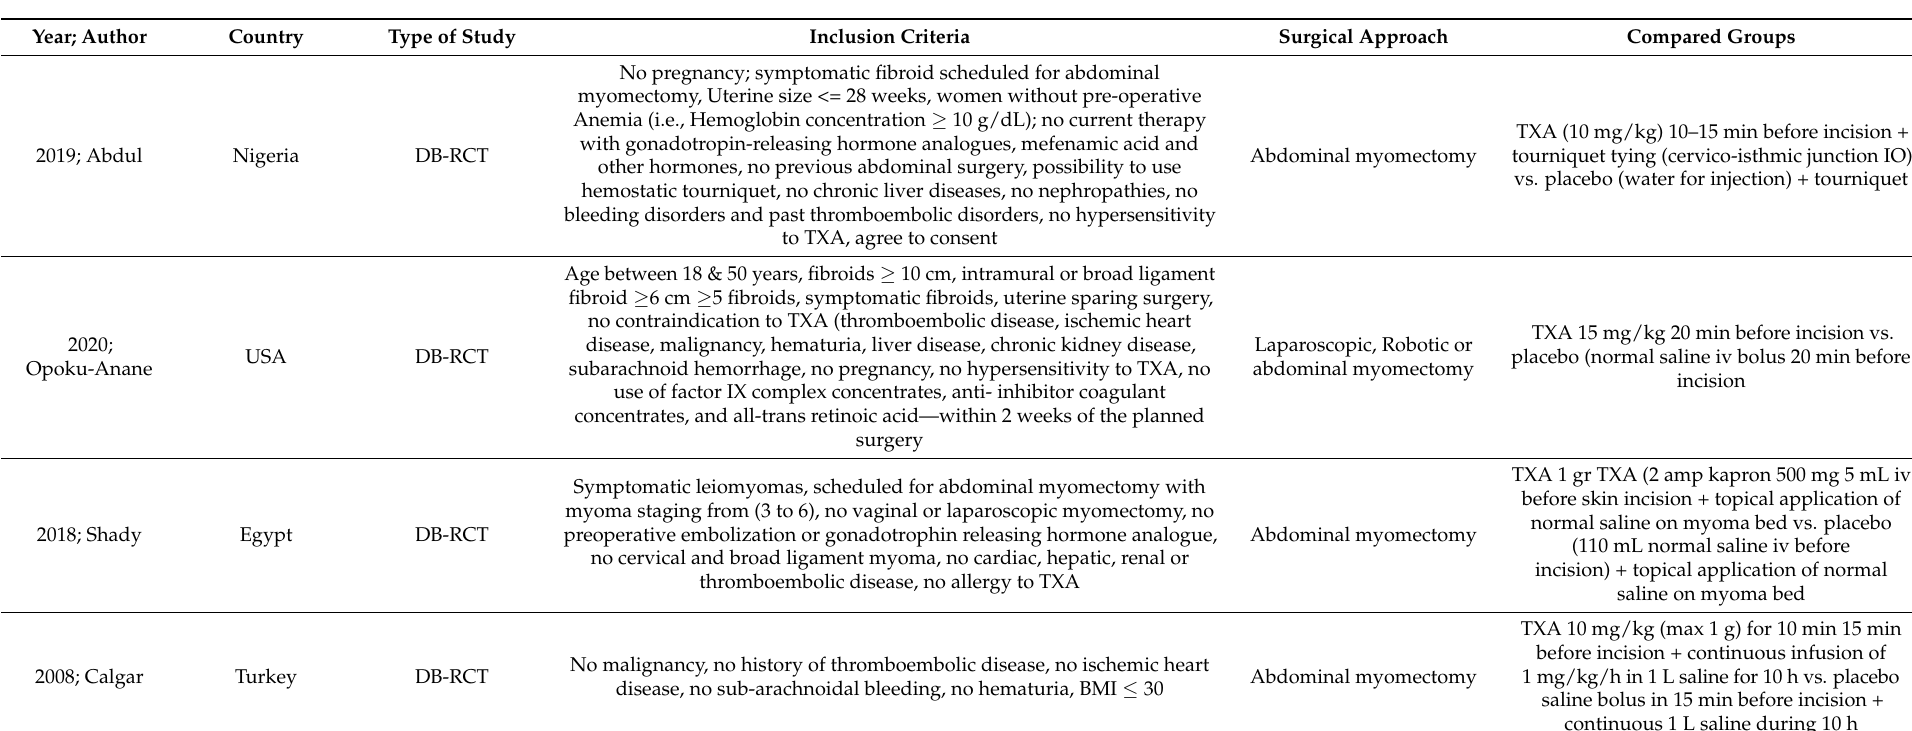
Table 1. Main characteristics of the included